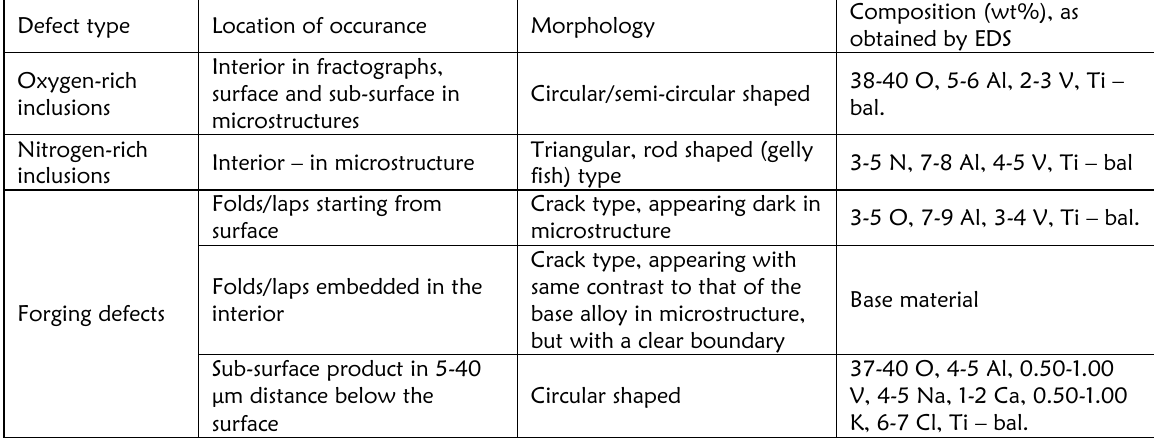
Table 5: Physical characteristics of various defects on diaphragm discs Defect type